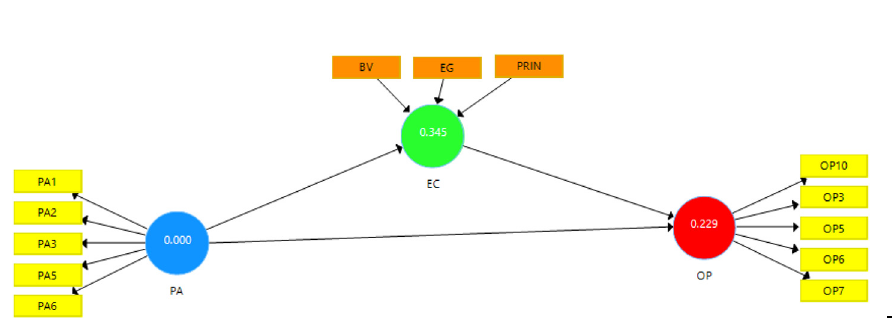
Figure 4. Predictive relevance for mediation model